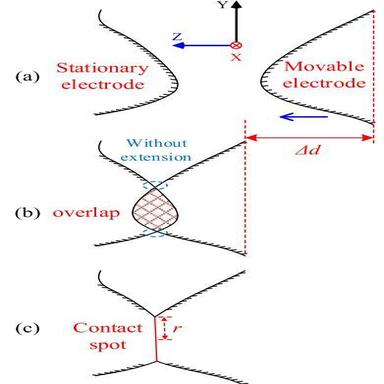
Schematic of one contact spot. (a)The movement of movable electrode. (b) Surface overlap. (c) Simplified contact spot.